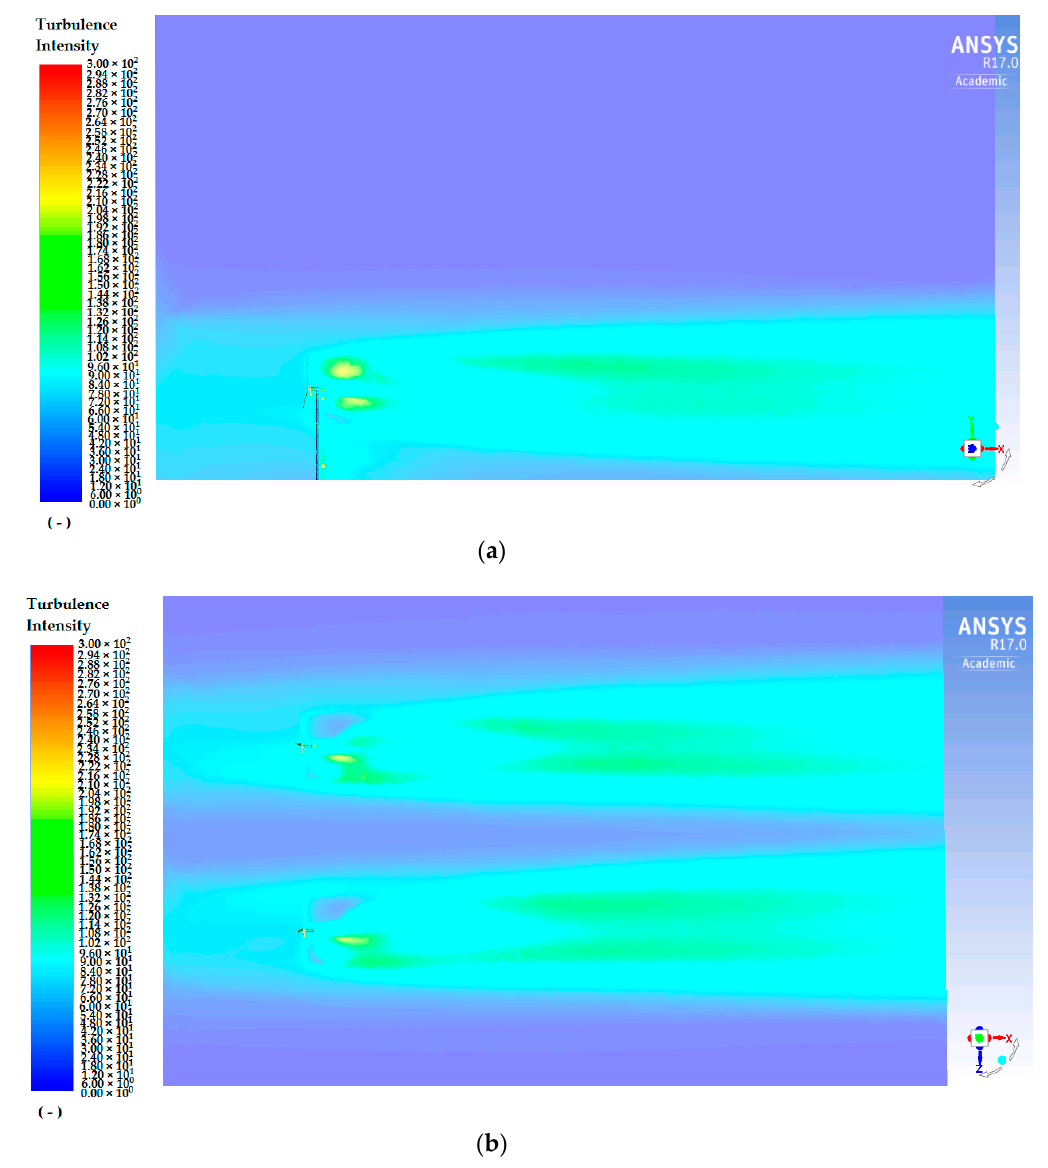
Figure 5. Turbulence Intensity (TI) contours of a second row of turbines, using a profile from a simulation from a first row of turbines. ( a ) Lateral view of the wake; and ( b ) top view of the wake.